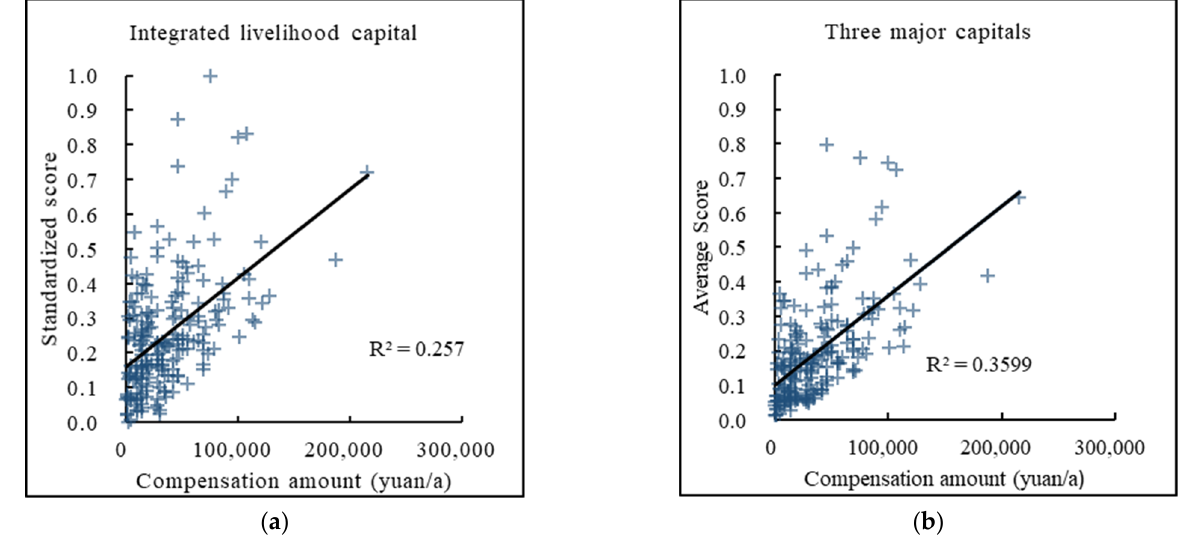
Figure 3. ( a ) The trend in the relationship between herder households’ integrated livelihood capital and compensation amount; and ( b ) between herder households’ three major types of livelihood capital and compensation amount. (scores ∈ (0, 1], Compensation amounts ∈ (229, 215,410)).